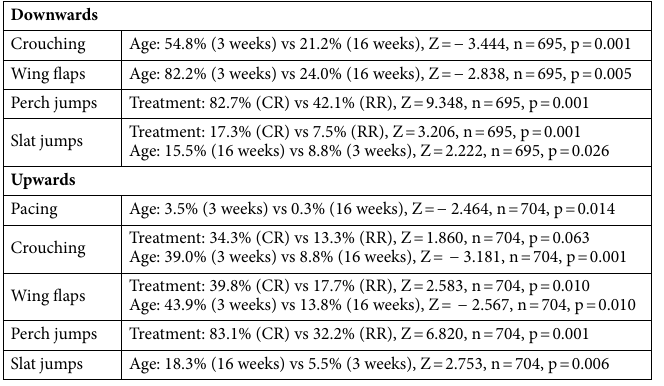
Table 2. Results for focal behaviour transitions. Separated for downwards and upwards transitions. Analysis was conducted for control reared (CR) and ramp reared (RR) treatments at the ages of 3 and 15–16 weeks of